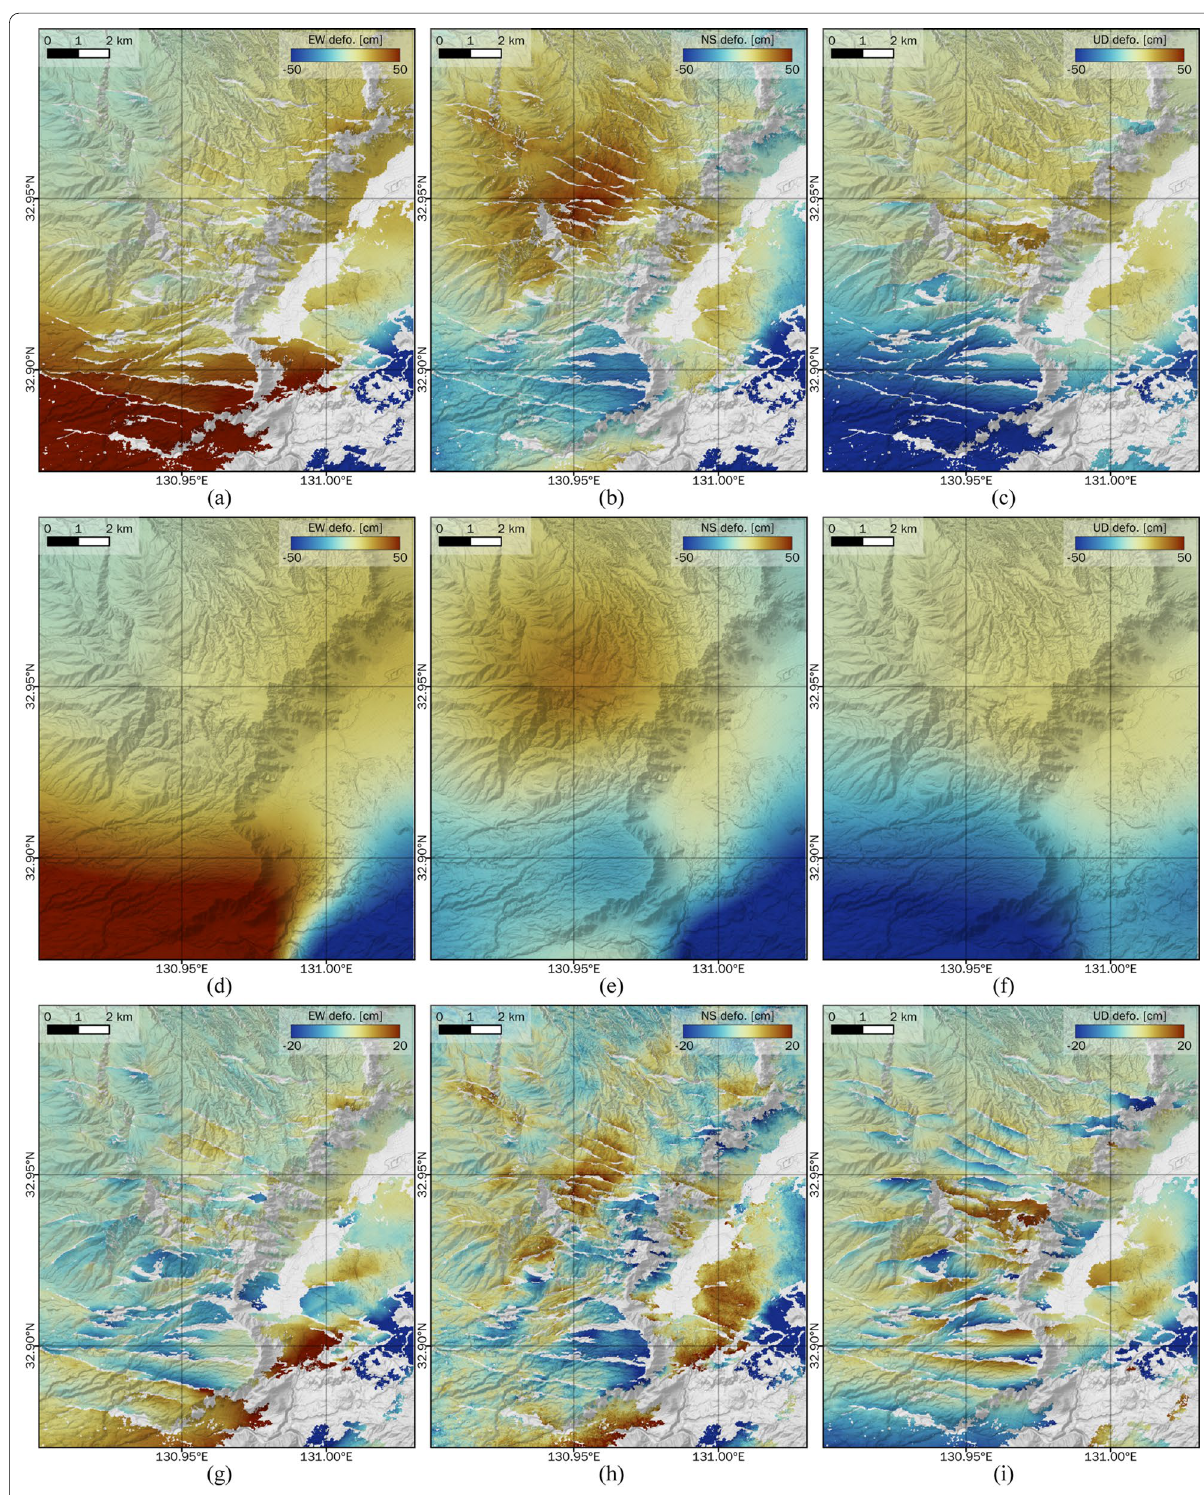
Fig. 11 3D deformation derived from the corrected unwrapping results. a – c Original. d – f Low-pass component by the Gaussian filter. g – i High-pass component. a , d , g East–west component. beh North–south component. c , f , i Up-down